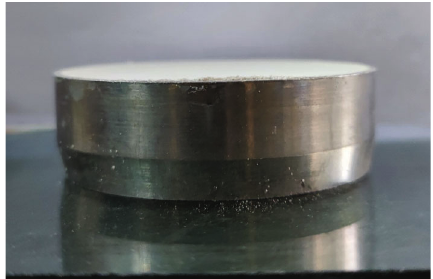
Figure 10: Before the con fi ned